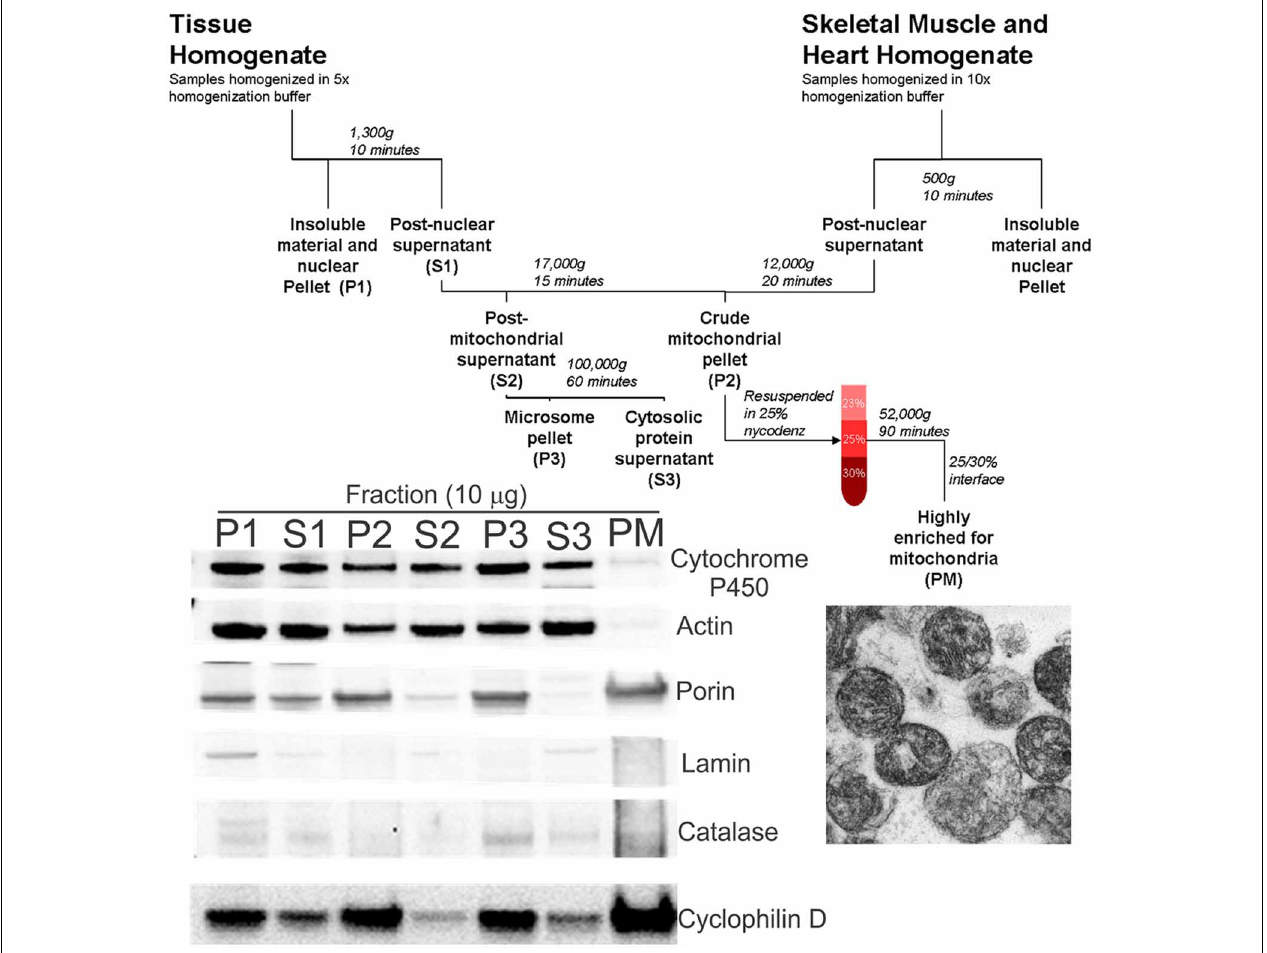
FIGURE 1 | Schematic diagram of tissue fractionation and experimental verification of mitochondrial enrichment and purity. Tissues were homogenized in appropriate buffer using a PT3100 polytron. After centrifugation to remove tissue and cellular debris, a crude mitochondrial pellet was obtained (fraction P2). The pellet was resuspended in 25% nycodenz and a highly pure mitochondrial fraction (fraction PM) was obtained by discontinuous gradient centrifugation.